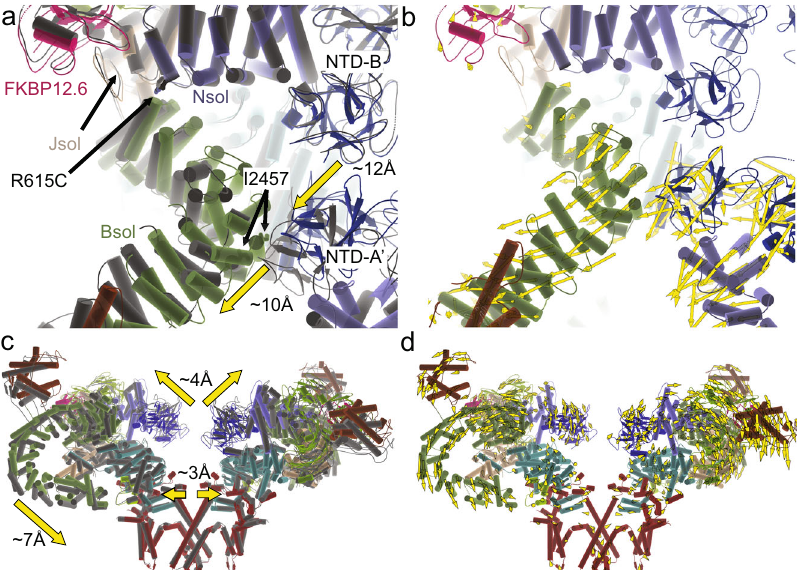
Fig. 3 The R615C mutation induces opening via disruption of Nsol – Bsol interactions. a Superposition, based on the Nsol region, for WT (colors) and R615C (black) pig RyR1 (pRyR1). Alpha helices are represented as cylinders. This shows the movement of the Bsol relative to the Nsol, and the widening of the gap between the N-terminal domains of two neighboring subunits. The prime in NTD-A ′ indicates that this is a different subunit. See also Movie S1. b Same view as in panel ( a ), showing the WT only, with yellow vectors showing the shifts >2 Å in the Bsol region compared to R615C pRyR1. c Side view of an overall superposition of WT (colors) and R615C (black) pRyR1. The major movements are indicated by arrows. Only two subunits are shown for clarity. See also Movie S2. d Same view as in panel ( c ), showing the WT pRyR1 only, with yellow vectors showing the shifts >2 Å throughout the protein going from WT to R615C